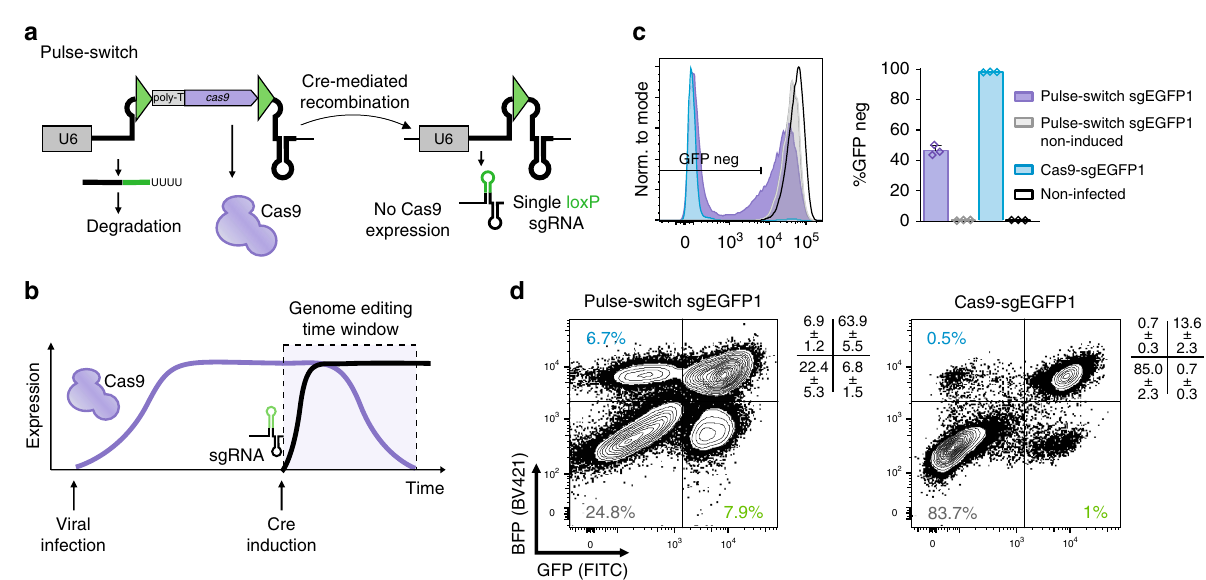
Fig. 3 CRISPR-Switch-Pulse. a , b Schematics of CRISPR pulse construct. The Cas9 cassette provides expression in a non-recombined state ( a , left) while sgRNA transcription is terminated by polythymidine signal (poly-T). Upon recombination the Cas9 cassette is removed and sgRNA is transcribed ( a , right) leading to a short time window of both sgRNA and Cas9 present in a cell ( b ). U6 – U6 promoter. Triangles represent recombination sites. c EGFP deletion ef fi ciency of CRISPR-Switch-Pulse with sgEGFP1 and constitutively expressed Cas9 with sgEGFP1 was compared in CreERT2, EGFP-positive mES cells. Error bars represent standard deviation ( n = 3). d Switch-Pulse and constitutive Cas9 lentivirus with sgEGFP1 guide RNA targeting both EGFP and EBFP2 was introduced to NIH3T3 cells encoding CreERT2, EGFP, and EBFP2. Ef fi ciency of single and double deletion was assessed with fl ow cytometry in FITC and BV421 channels. Plus refers to